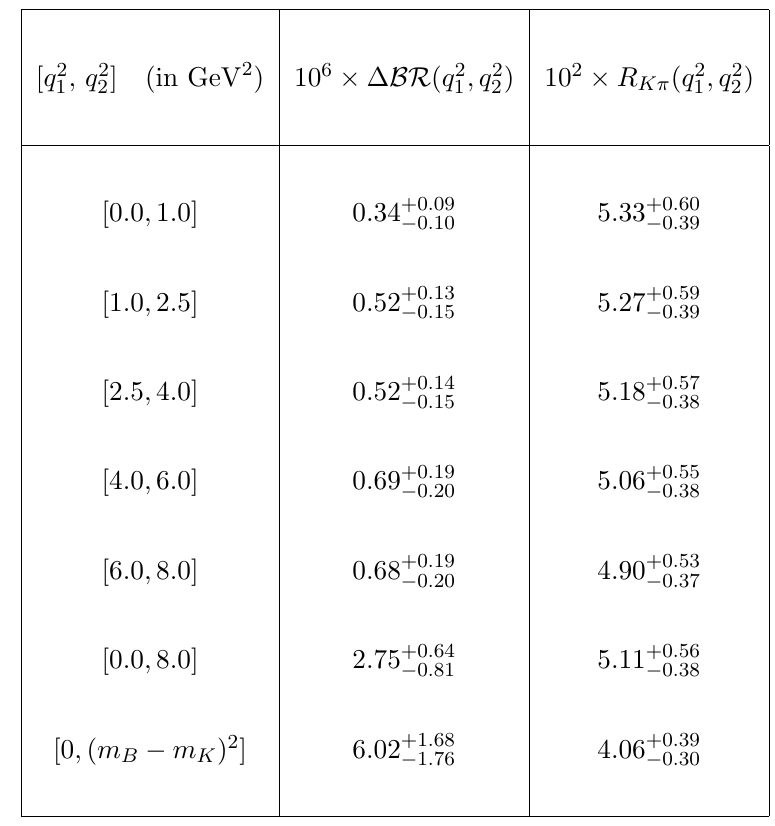
Table 3 . Theory predictions for the partial branching fractions of B ! K(cid:23)(cid:23) and the binned distributions of the precision observable R K(cid:25) ( q 2 the B -meson LCSR and the z -series